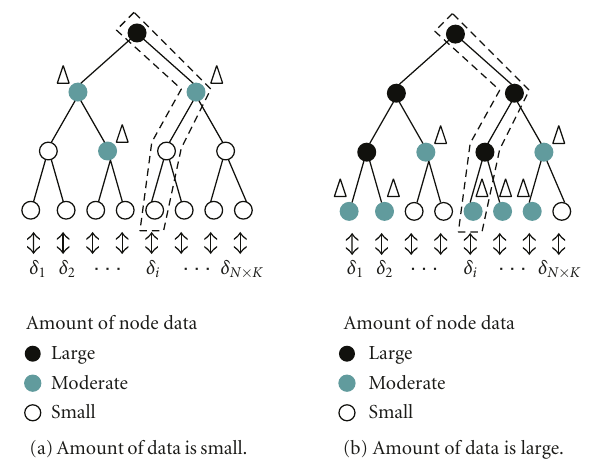
Figure 2: Tree structure for shifts estimation.